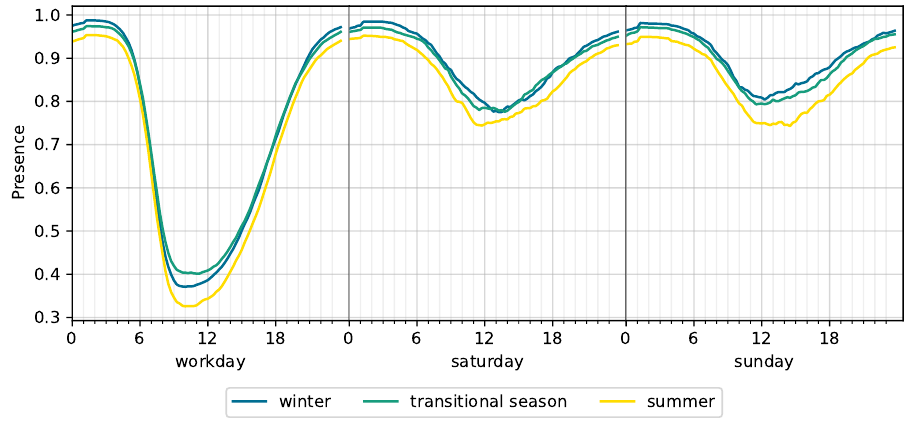
Figure 4. Mean presence of Electric Vehicles ( EVs ) at home parking lots, based on